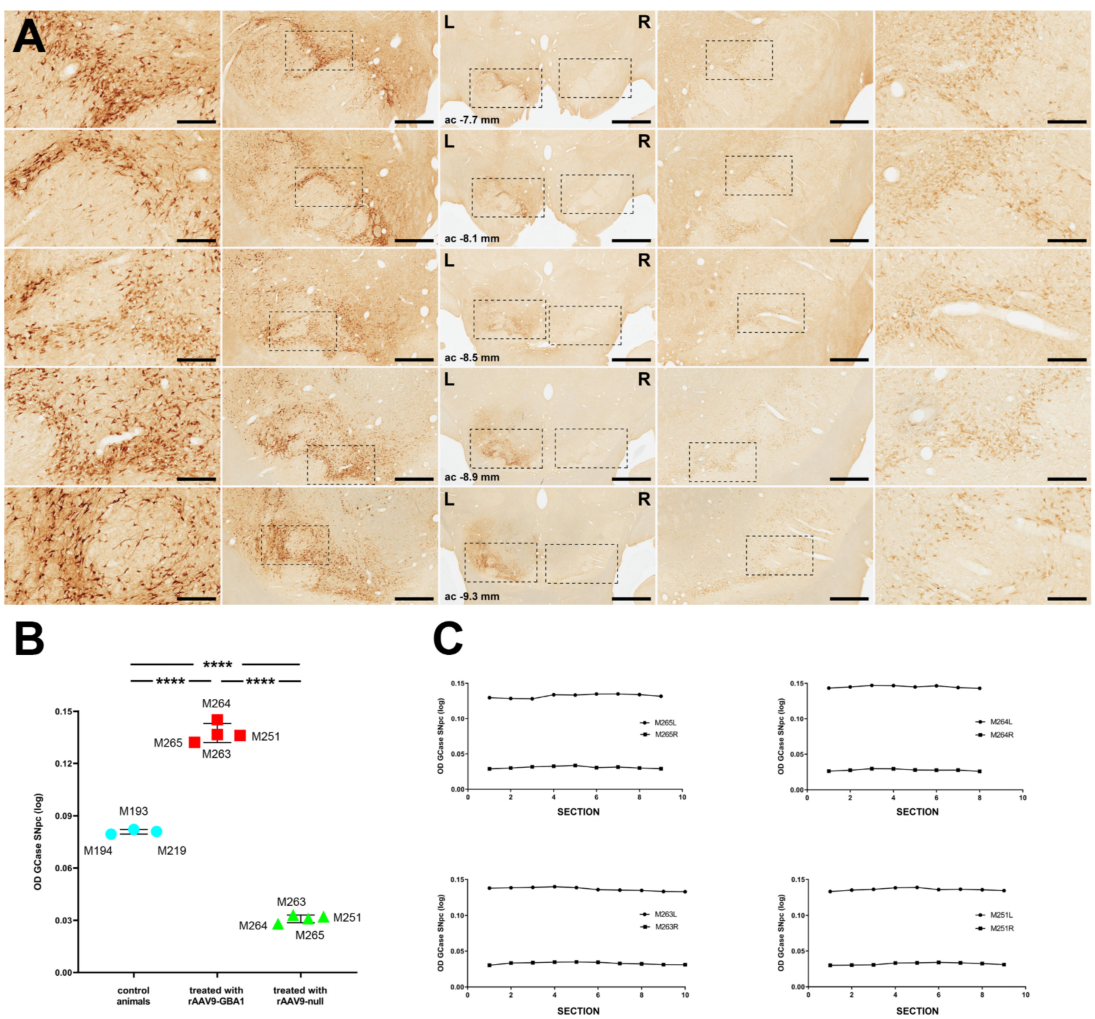
Figure 4. Immunohistochemical detection of GCase in the SNpc of NHPs. ( A ) Eight weeks after the delivery of two deposits of 10 µ L of rAAV9-GBA1 into the left SNpc and 10 µ L of AAV9-null into the right SNpc, high levels of GCase expression were found in the left SNpc (e.g., the one injected with the therapeutic vector). By contrast, only baseline GCase levels were detected in the right SNpc. Furthermore, it is worth noting that the entire extent of the left SNpc was successfully transduced with rAAV9-GBA1 since GCase+ neurons were found throughout the full rostrocaudal extent of the SNpc, ranging from rostral SNpc levels (ac—7.7 mm) to the caudalmost territories (ac—9.3 mm). Scale bars are 3000 µ m for A-G (low-magnification panels), 1000 µ m for panels A1-G1 and A3-G3, and 300 µ m for high-magnification insets (panels A2-G2 and A4-G4). ( B ) Optical densities of GCase stains as measured in the side treated with rAAV9-GBA1 (left SNpc; red), in the side treated with the control vector rAAV9-null (right SNpc; green), compared to baseline GCase optical densities observed in three naïve animals at the level of the SNpc. ( C ) Illustrations showing that enhanced GCase expression levels in the left vs. right SNpc are maintained throughout the entire rostrocaudal extent of the SNpc. ****: p <